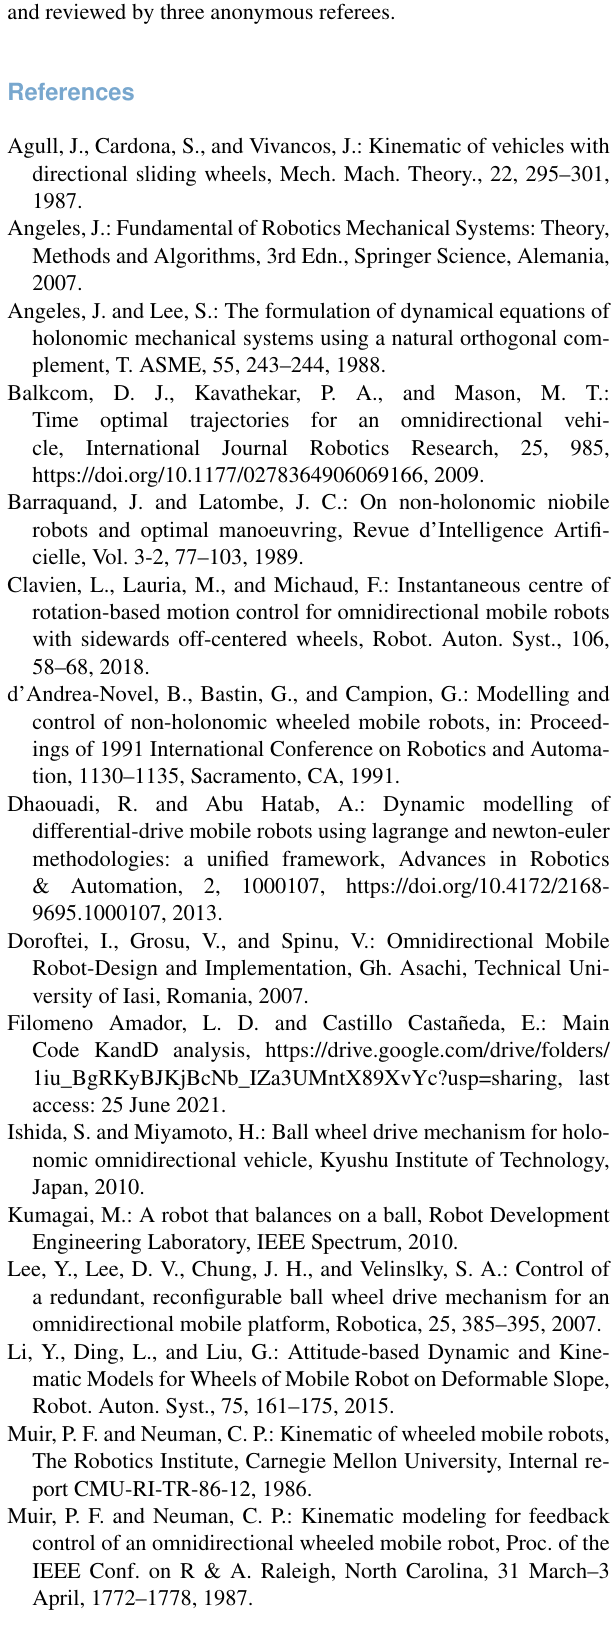
Figure 12. Torque inclination.